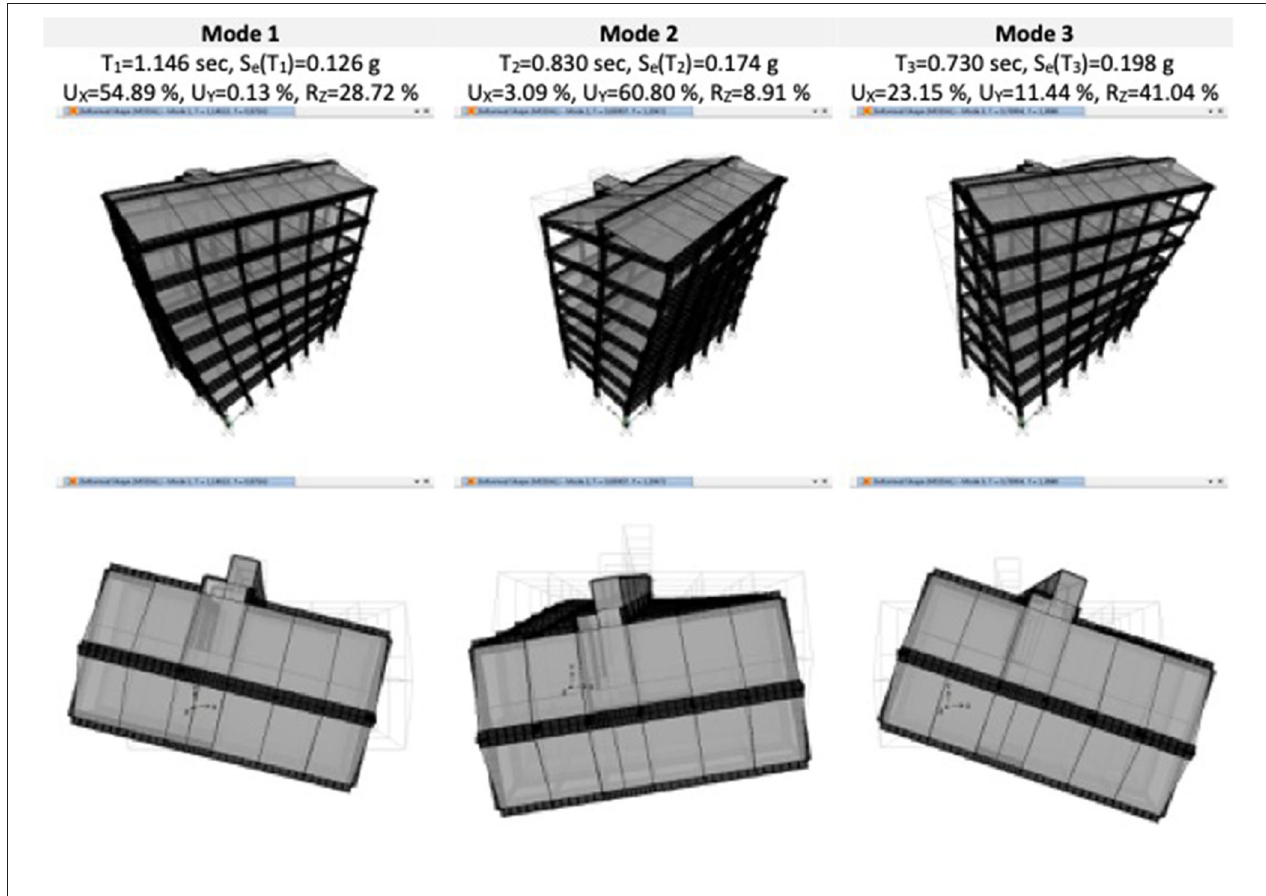
FIGURE 4 | Modal analysis results with the FB model. First three vibration modes.